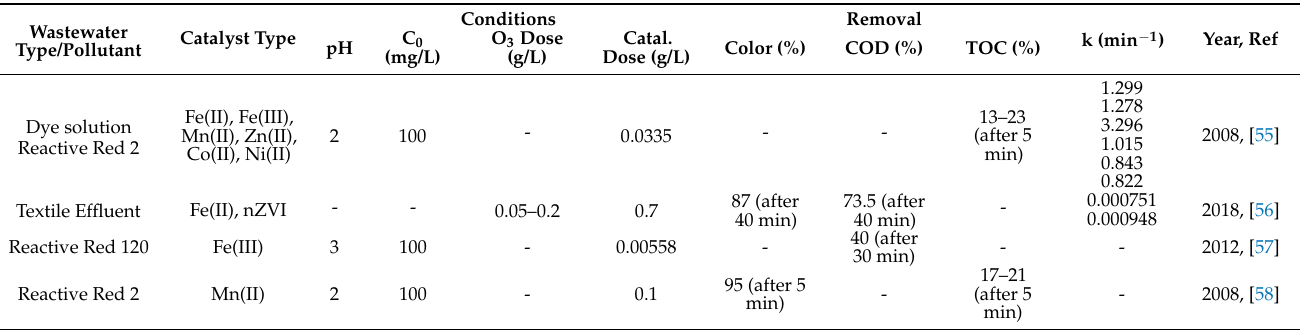
Table 2. Results of homogeneous catalytic